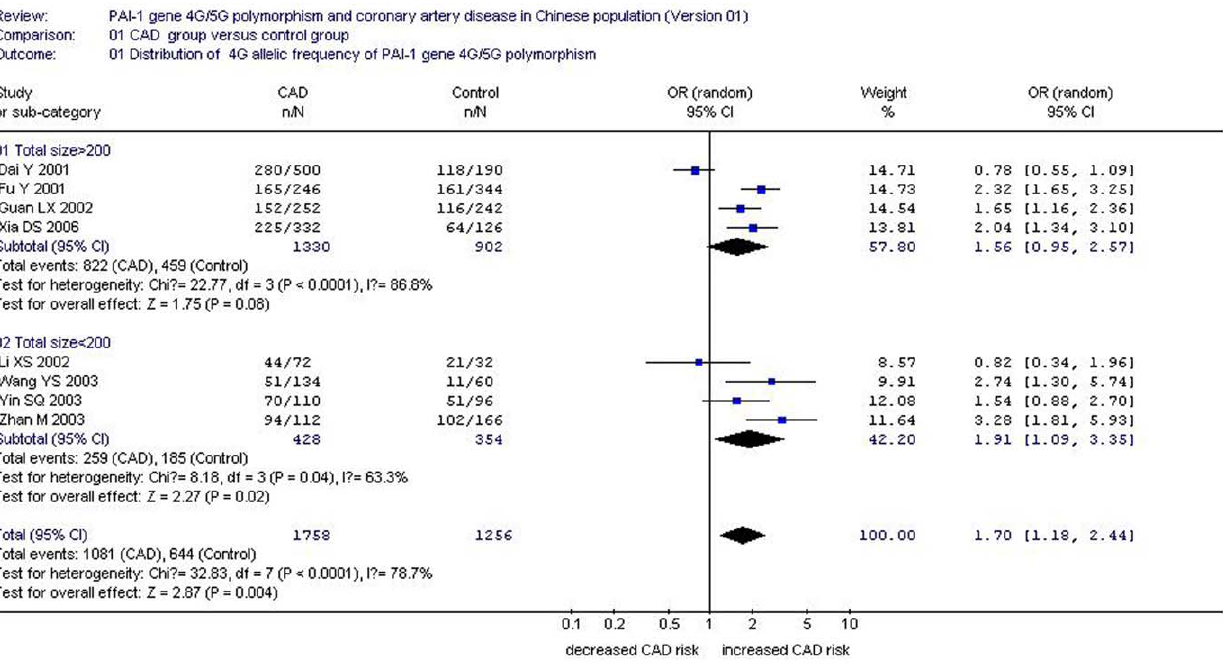
Figure 2. Forest plot of coronary artery disease associated with 4G/5G gene polymorphism (distribution of 4G allelic frequency of plasminogenactivatorinhibitor-1 4G/5G gene) stratified by total size.